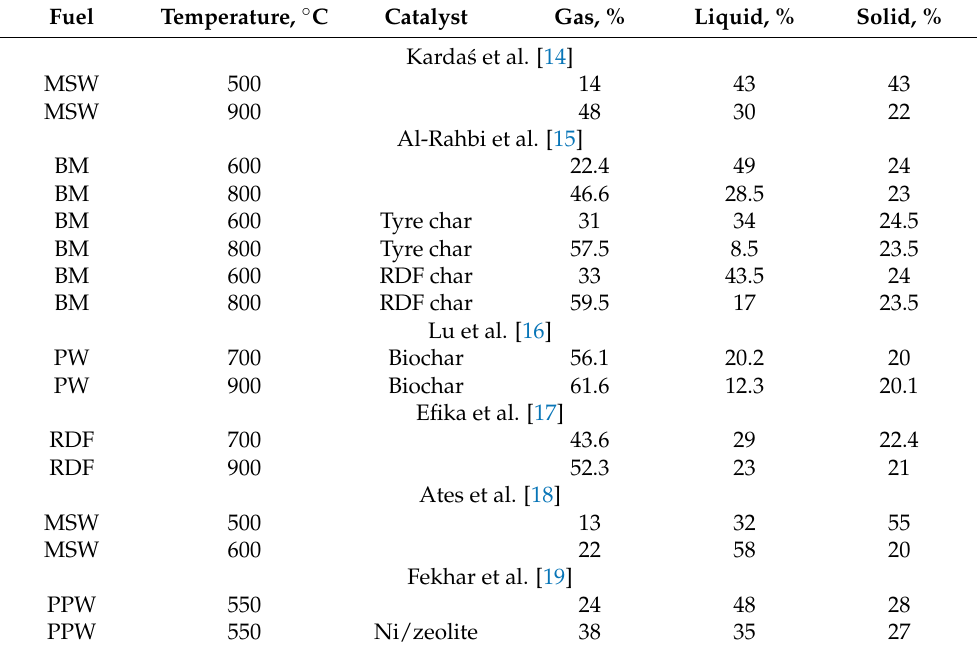
Table 2. Parameters of municipal solid waste (MSW), biomass pyrolysis (BM), plastic waste (PW), residue-derived fuel (RDF), plastic and paper waste, and product